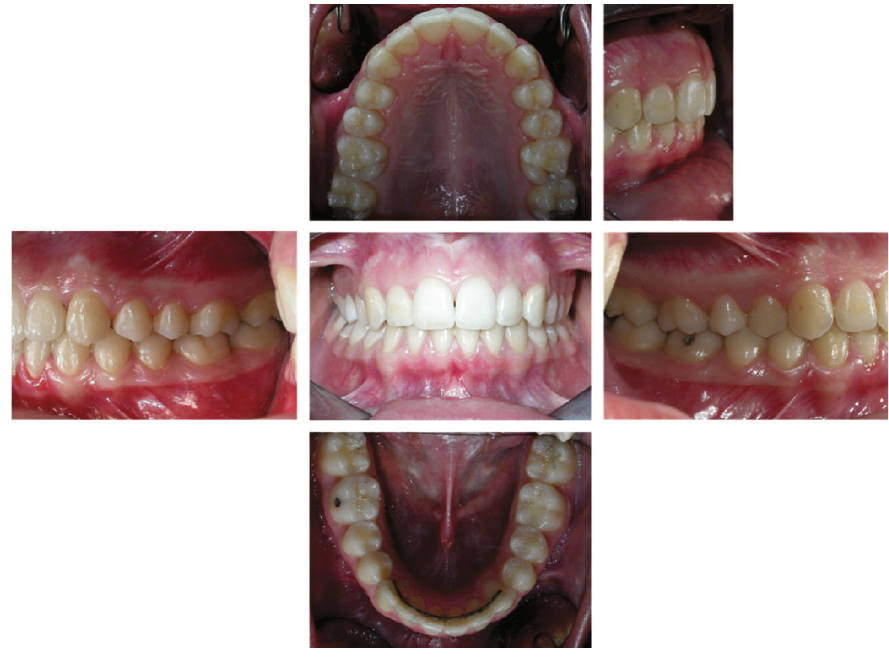
Figure 14: 4-year follow-up intraoral photographs.